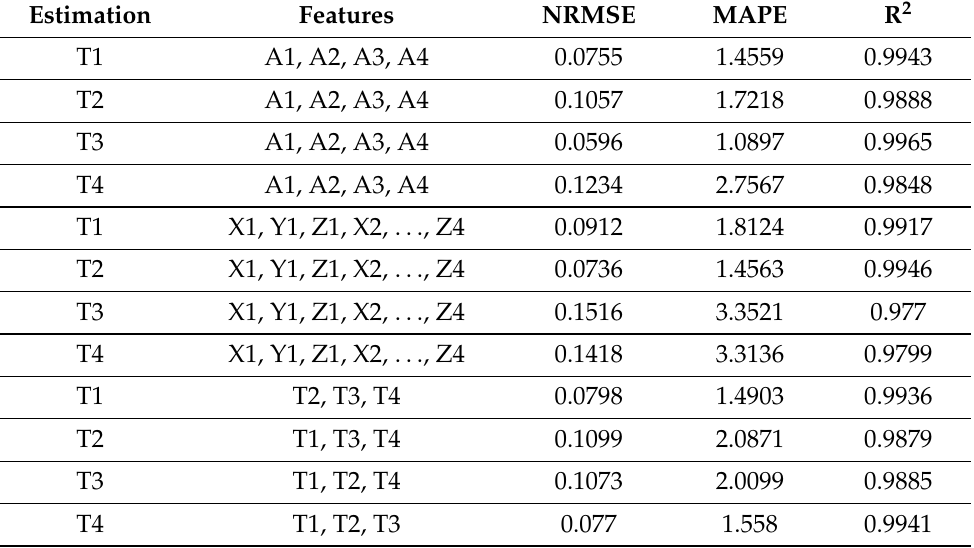
Table 3. Tension estimation results for some attempts choices of